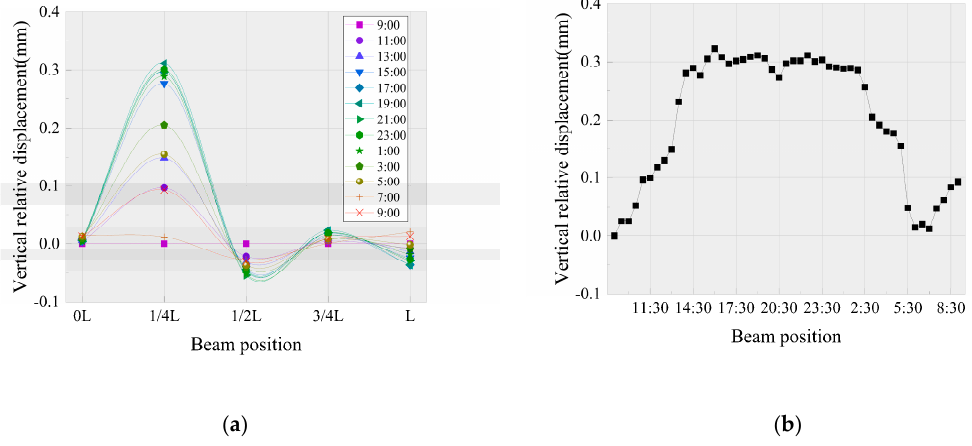
Figure 8. Vertical relative displacement between the base plate and beam body. ( a ) Vertical relative displacement; ( b ) vertical relative displacement time history curve at 1/4 L.